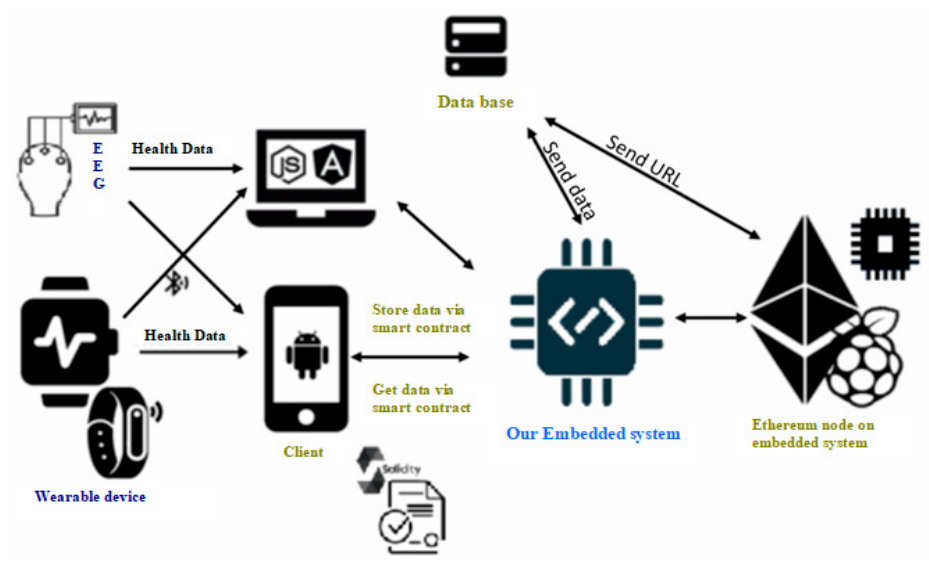
Figure 2. Proposed minimalist system.